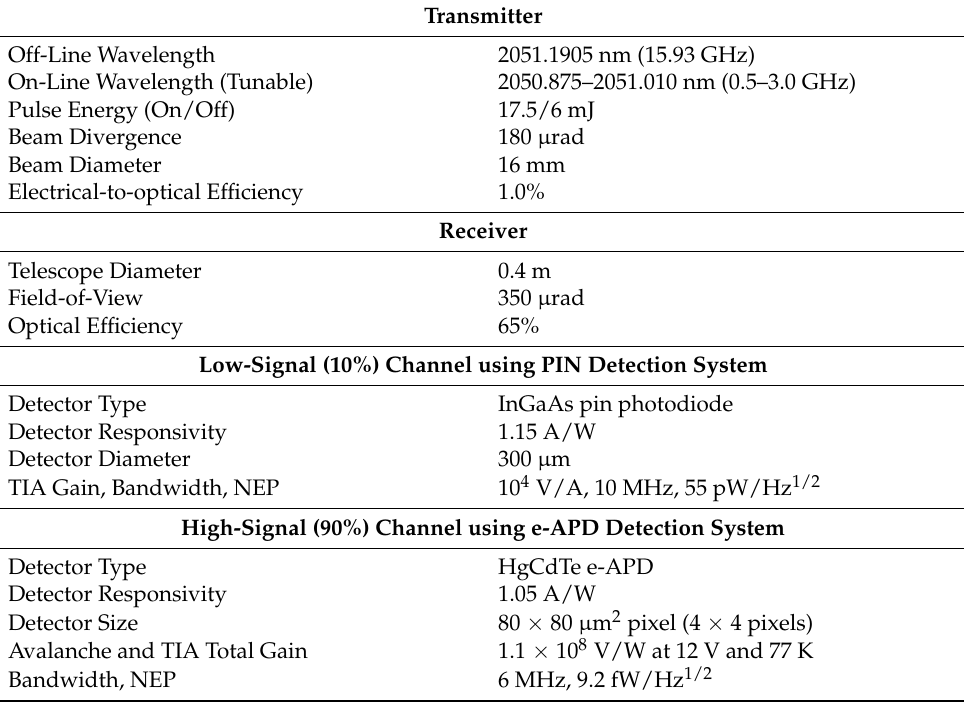
Figure 1. A schematic for the 2- µ m pulsed IPDA lidar for atmospheric CO 2 measurements. The transmitter is based on 2- µ m double-pulse high-energy laser, seed laser and transmitter control and monitors unit for setting the wavelength of each transmitted pulse and time synchronization. The receiver telescope focuses return radiation onto two detection channels based on InGaAs PIN and MCT e-APD detectors. Data acquisition and storage unit records and stores the IPDA data. A computer is used for instrument operation control, monitoring, and real-time data processing. Table 1. Parameters and relevant settings for the 2- µ m IPDA Lidar during airborne double-pulse operation for atmospheric CO 2 measurements.